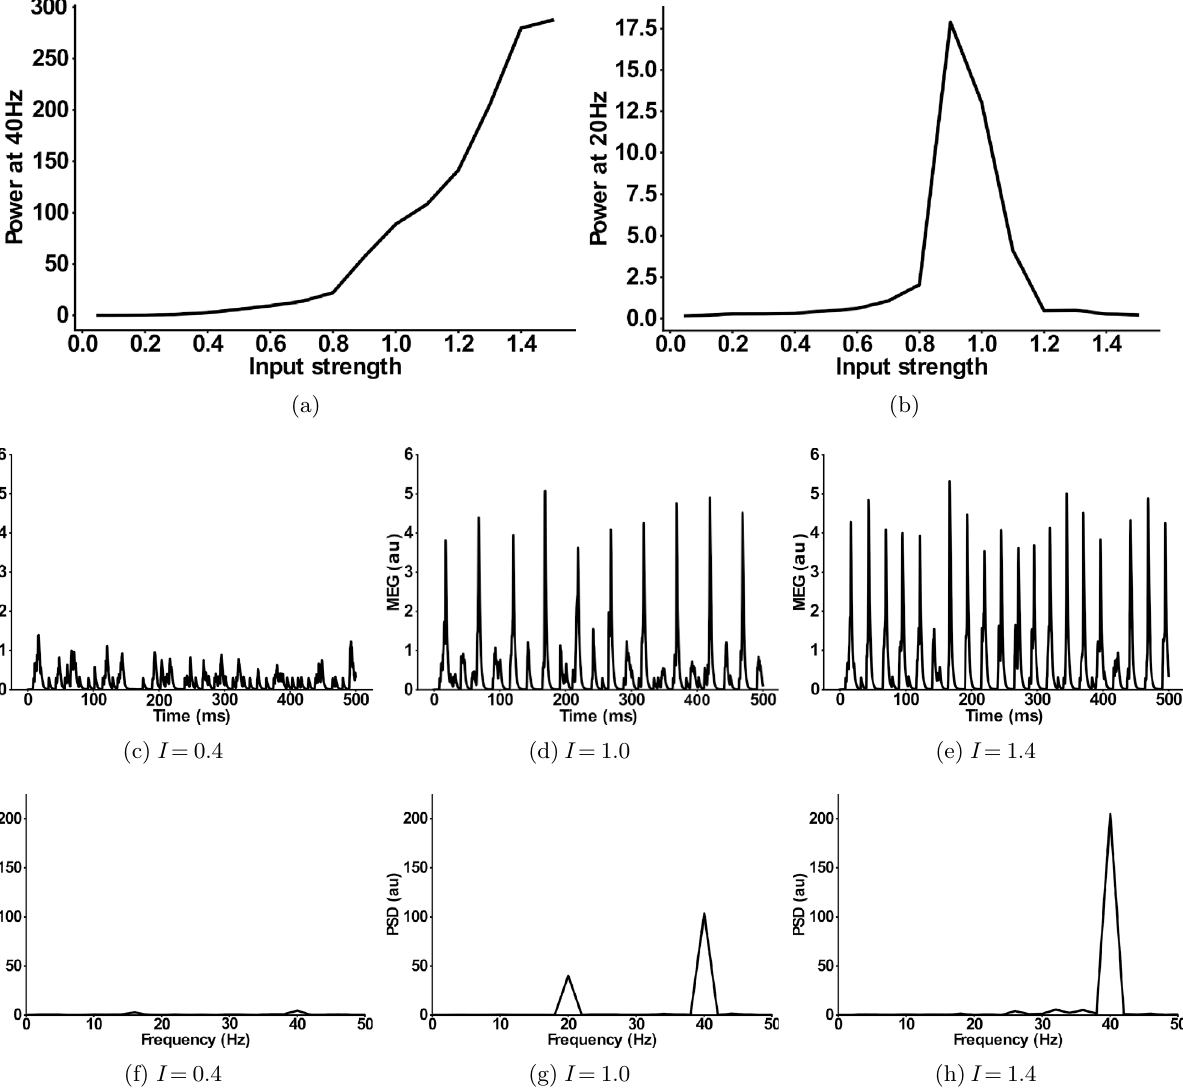
Figure 3. Input dependence of the 20 Hz component in the ‘IPSC-SCZ-like’ model. ( a ) Power at 40 Hz in response to 40 Hz drive as a function of the input strength. ( b ) Power at 20 Hz in response to 40 Hz drive as a function of the input strength. ( c – e ) Simulated MEG signals for three different input strengths: ( c ) I = 0.4 Input strength too low to drive synchronization. ( d ) I = 1.0 Input strength high enough to drive synchronization and to allow for a beat-skipping behaviour. ( e ) I = 1.4 Input strength too strong for beat-skipping